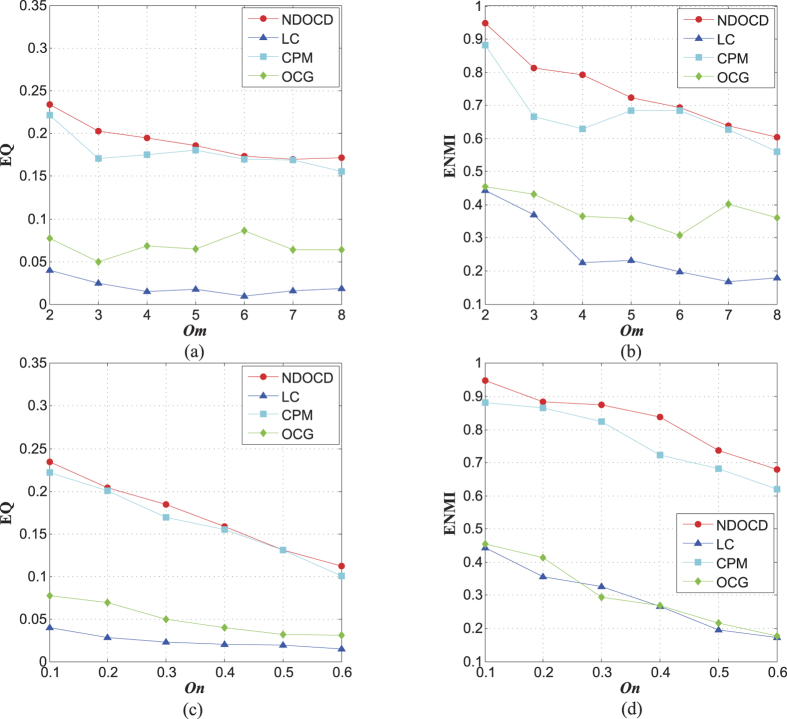
The effects of overlapping diversity om and overlapping density on/n on synthetic networks.(a) EQ for networks with n = 500, k = 25, kmax = 50, u = 0.4, τ1 = 2, τ2 = 1, cmax = 50, cmin = 10, om = 2 ~ 8, on/n = 10%, (b) ENMI for networks with n = 500, k = 25, kmax = 50, u = 0.4, τ1 = 2, τ2 = 1, cmax = 50, cmin = 10, om = 2 ~ 8, on/n = 10%, (c) EQ for networks with n = 500, k = 25, kmax = 50, u = 0.4, τ1 = 2, τ2 = 1, cmax = 50, cmin = 10, om = 2, on/n = 10% ~ 60%, (d) ENMI for networks with n = 500, k = 25, kmax = 50, u = 0.4, τ1 = 2, τ2 = 1, cmax = 50, cmin = 10, om = 2, on/n = 10% ~ 60%.